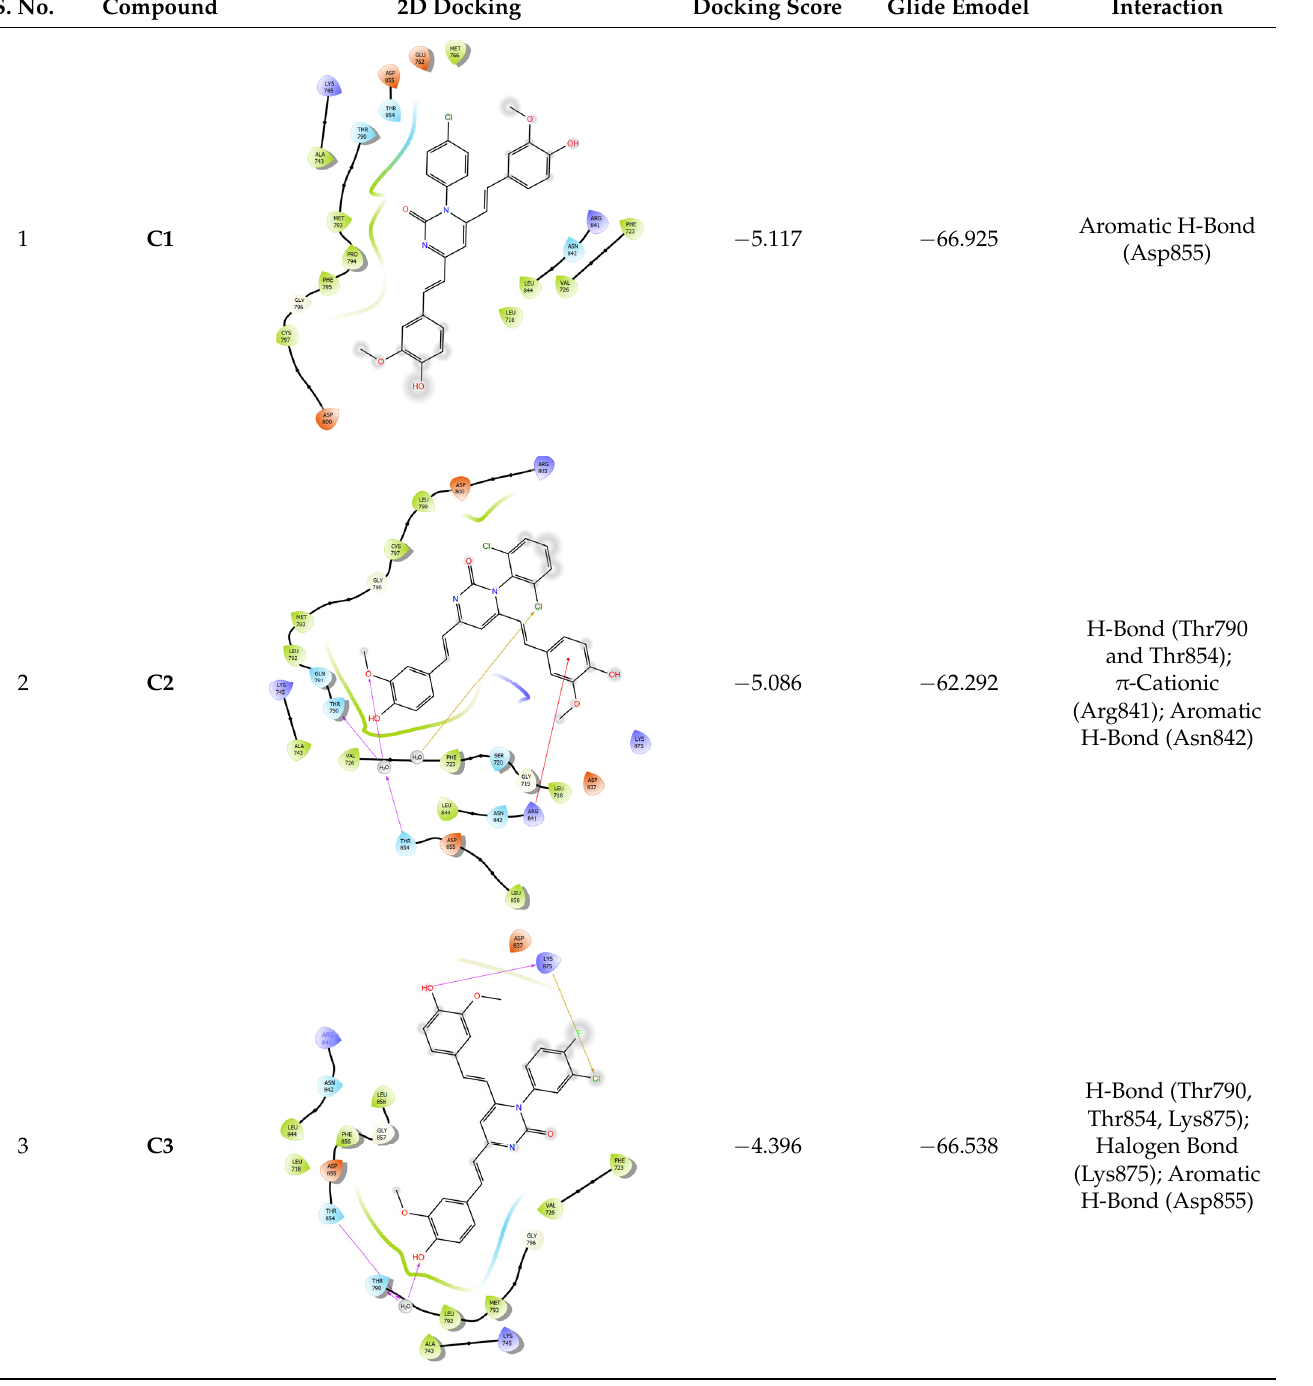
Figure 6. The 3D interactions of ligand C3 against the active site of EGFR (binding affinity = − 4.396 kcal/mol)